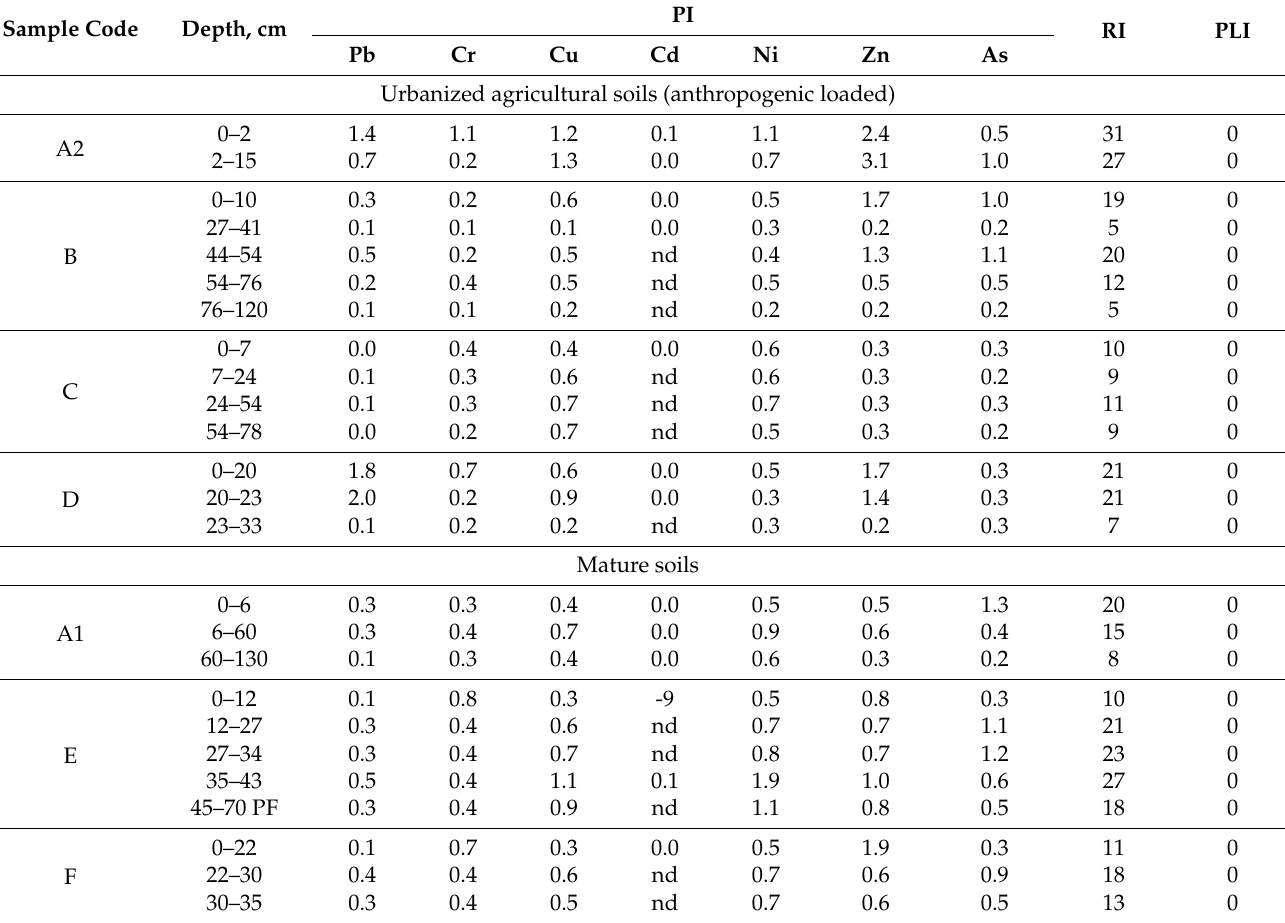
Table 7. PI, RI, and PLI indices values for each soil